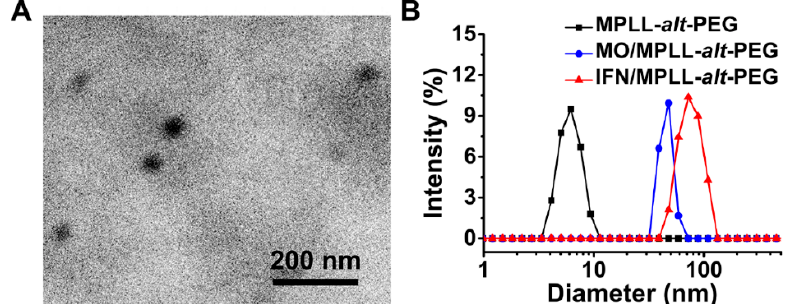
Figure 3. Self-assembly of MPLL- alt -PEG micelles. ( A ) TEM images of IFN / MPLL- alt -PEG micelles; ( B ) hydrodynamic diameters of free MPLL- alt -PEG, MO / MPLL- alt -PEG, and IFN / MPLL- alt -PEG micelles. IFN: recombinant human interferon α -2b; MO: methyl orange. Table 2. Hydrodynamic diameters and zeta potential of free copolymer and drug-loaded micelles. Samples